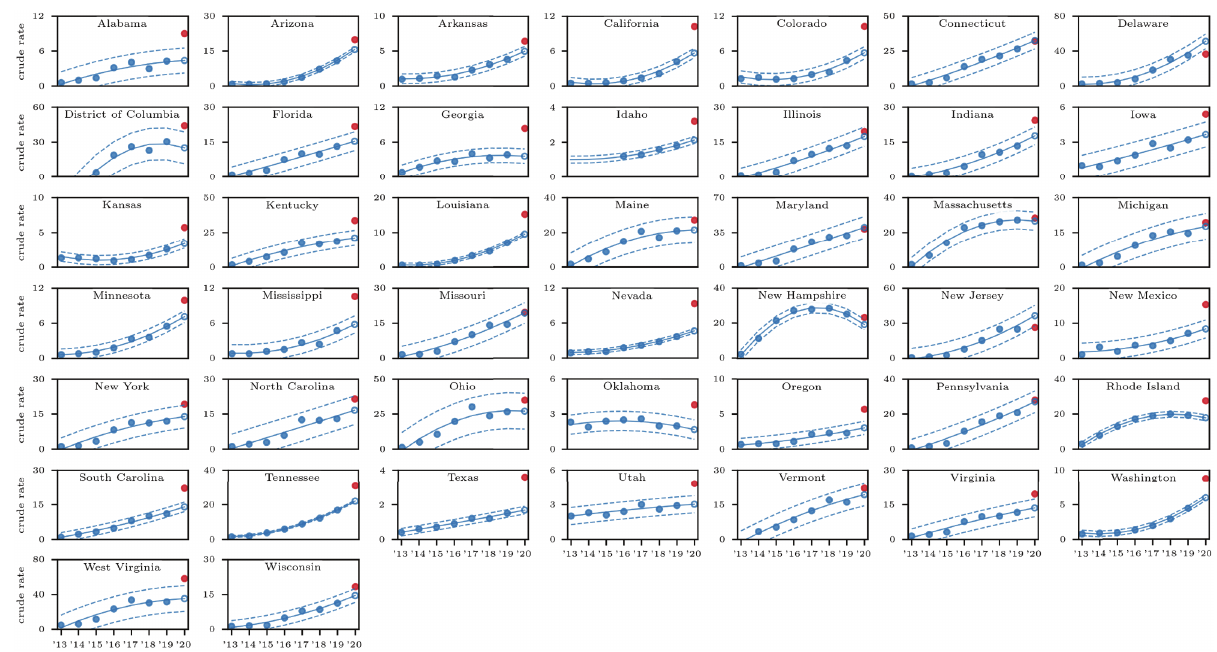
Fig 3. State-by-state fatal overdose trends induced by fentanyl (T40.4) for all races and all genders. Solid lines represent the 2013–2019 quadratic regression; dotted lines correspond to values three times above and below the regression by three times the standard deviation calculated from 2013– 2019 data; the open circle is the 2020 projection, the filled red dot is the actual data. In most (but not all) states trends mirror those observed for overall fatal overdoses shown in Fig 2. There is insufficient data for Alaska, Hawaii, Montana, Nebraska, North Dakota, South Dakota, Wyoming.